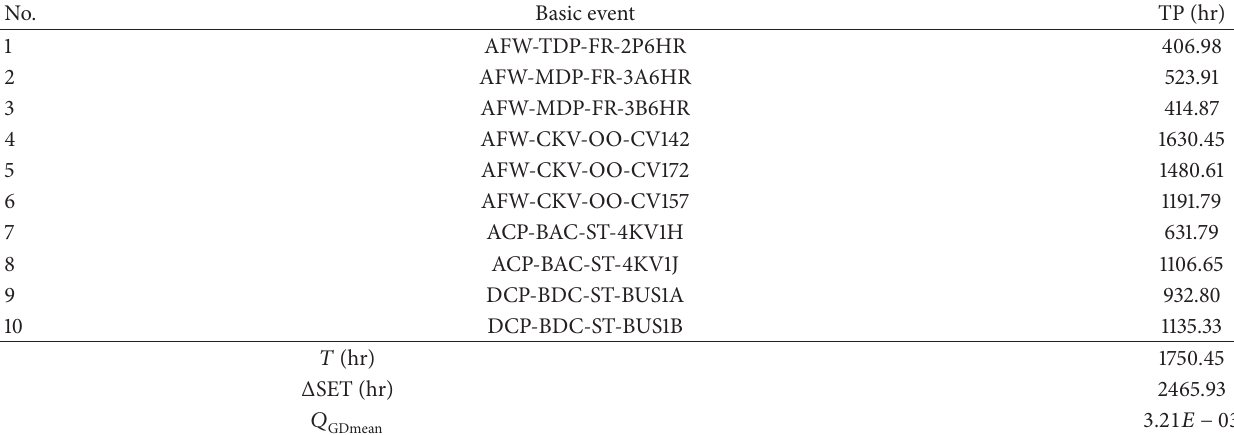
Table 9: Obtained optimal test placement times for case scenario 2 with consideration of the Δ SET and time interval 𝑇 .